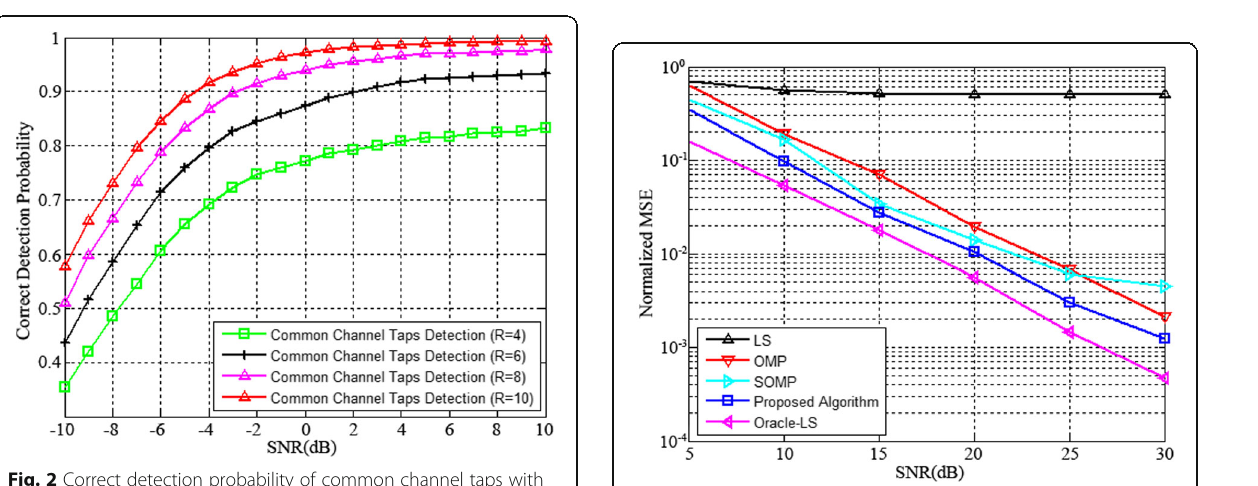
Fig. 3 The NMSE with different